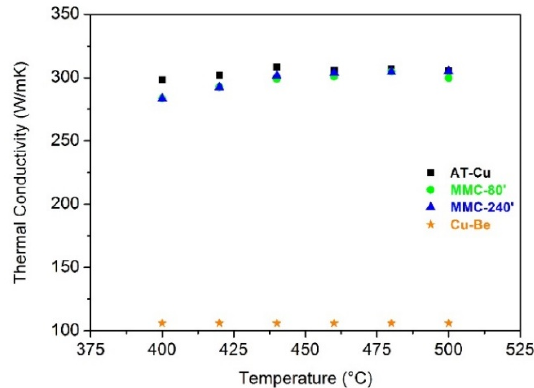
Figure 9. Thermal conductivity of sintered samples.